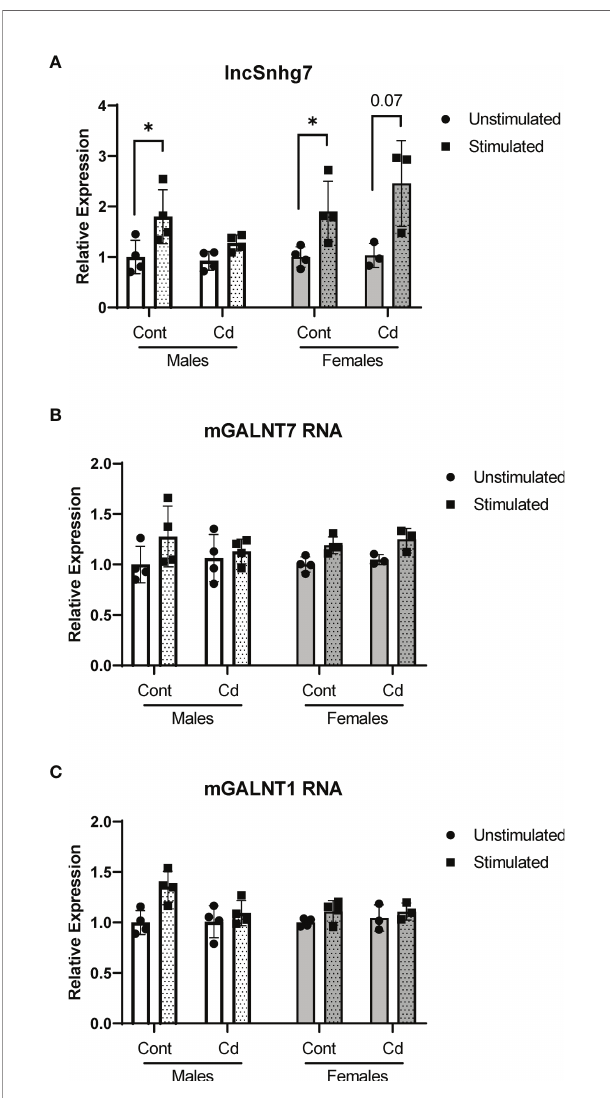
FIGURE 4 | Direct exposure to Cd does not reproduce effects of prenatal Cd exposure. Male and Female mice (8 weeks) were exposed to 21 days of CdCl 2 via drinking water. CD4 + CD25 - T conventional cells were isolated from total splenocytes. Cells were cultured in the presence of anti-CD3/CD28 magnetic beads for 0 and 16 hours prior to RNA isolation. lncSnhg7 (A) , GALNT1 (B) , and GALNT7 (C) expression was analyzed by qPCR. using ratio paired t-tests between stimulated and unstimulated samples with correction for multiple comparisons using the Holm-S ̌ ı ́ da ́ k method in post-hoc analysis. *p < 0.05. n = 3-4 per